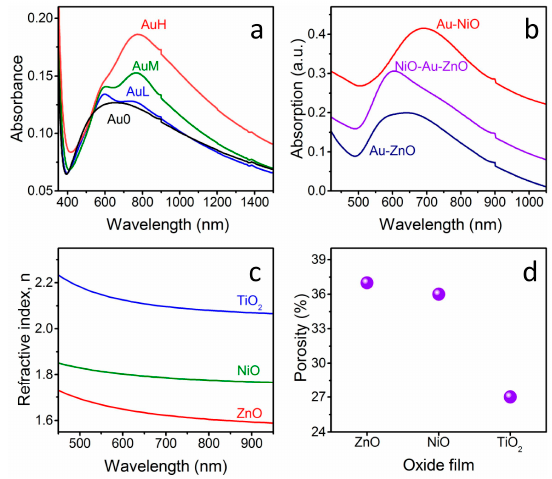
Figure 1. ( a ) Optical absorption spectra of TiO 2 -NiO double layer with different Au nanoparticles (NPs) amount embedded in between. Au surface coverages: L = 6%, M = 19% and H = 35%; ( b ) Optical absorption spectra of Au-ZnO, Au-NiO and NiO-Au-ZnO nanocomposites